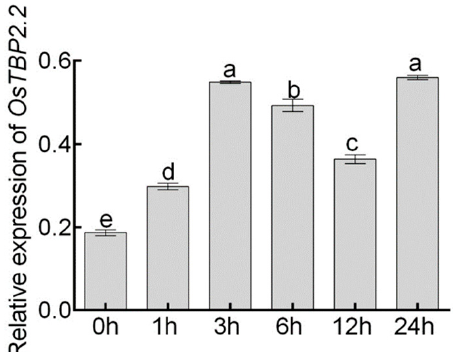
Figure 3. Relative expression analysis of OsTBP2.2 under PEG treatment. Relative expression level of OsTBP2.2 in the shoot of WT-DJ under drought stress. Rice seedlings were treated with IRRI solution containing 15% PEG6000 and harvested at di ff erent time points (0, 1, 3, 6, 12 and 24 h). Error bars: SE ( n = 3). Significant di ff erences are indicated by di ff erent letters. ( p <